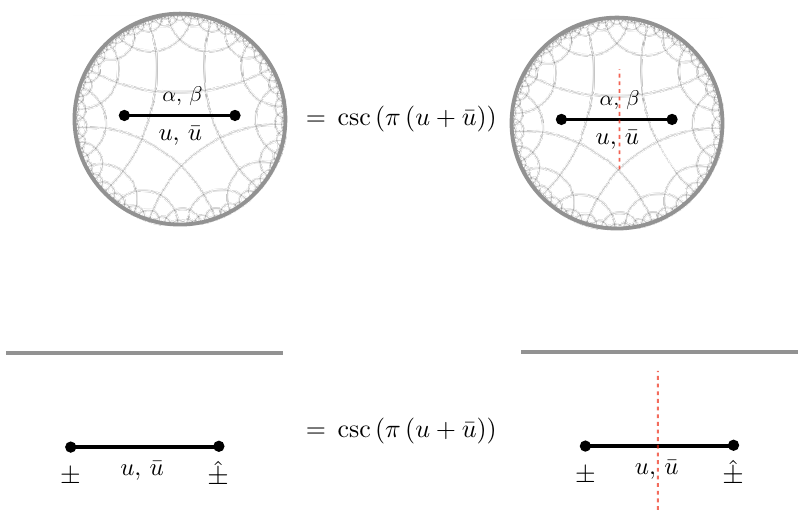
Figure 10. At the level of the Mellin-Barnes representation the full bulk-to-bulk propagator in (EA)dS can be reconstructed from its discontinuity (2.33) by multiplying with the factor csc ( π ( u + ¯ u ))